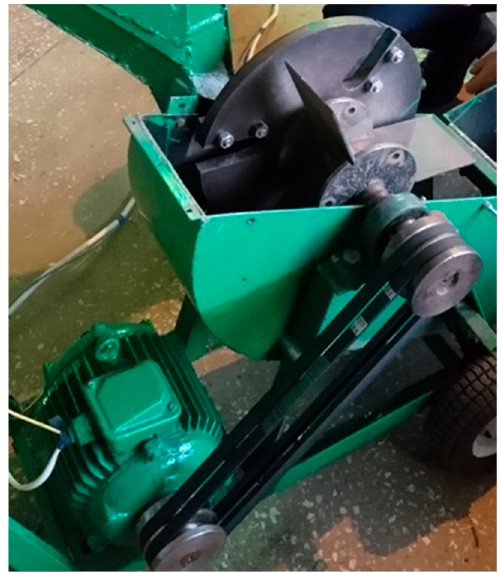
Figure 4. Branch chopper with a disc cutting system. The middle class of choppers is equipped with engines with a power of 2 to 2.5